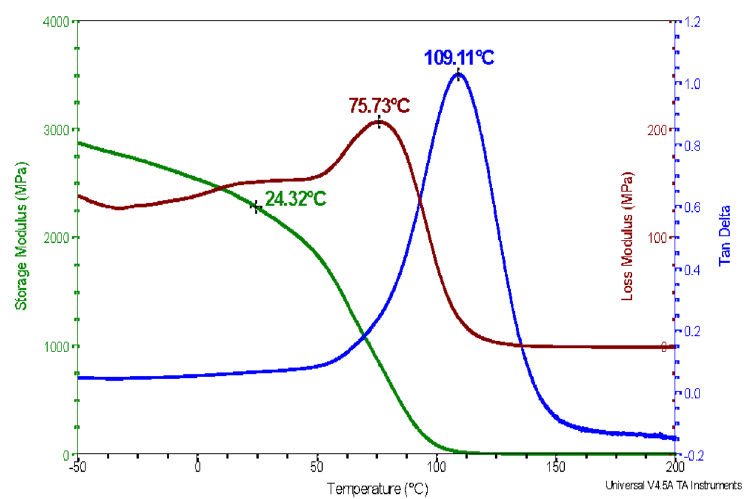
Figure 5. Thermal analysis curve of Polymer D obtained from single-frequency